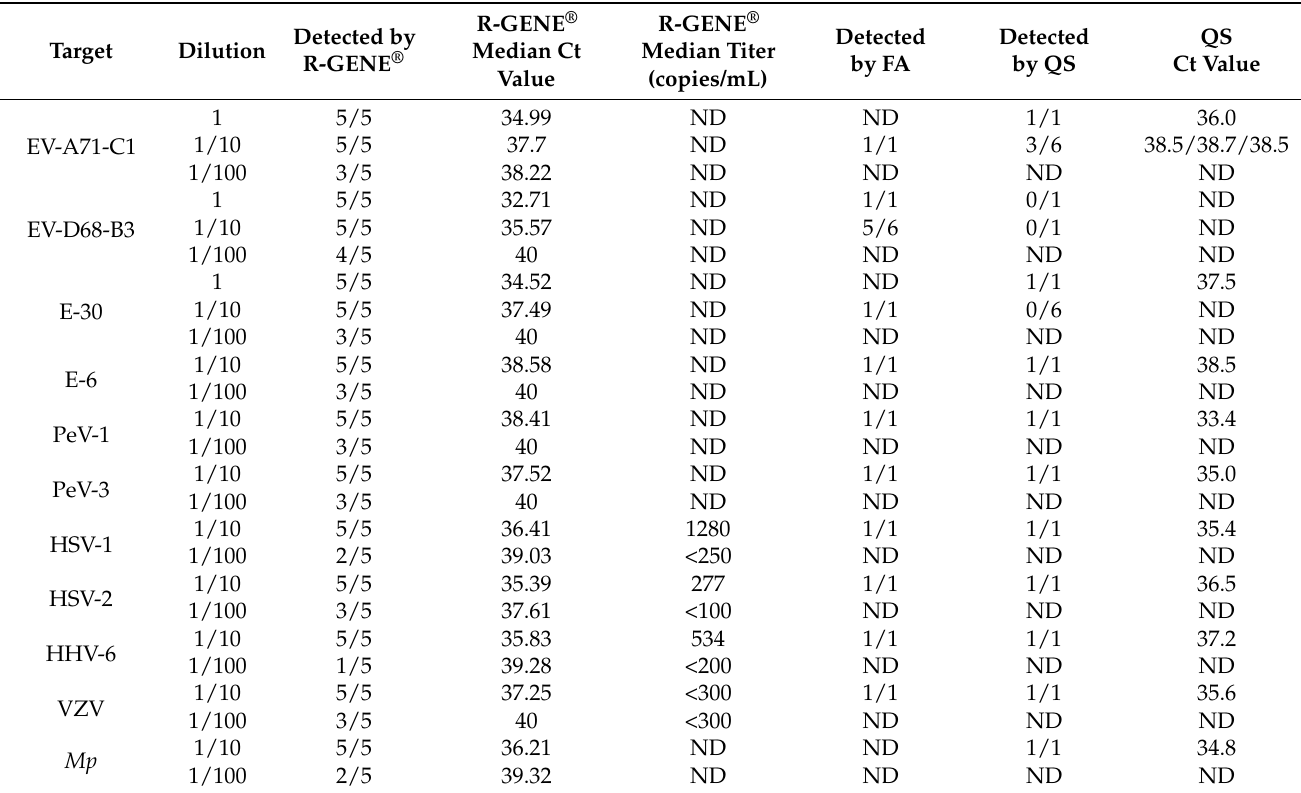
Table 2. Detections of low viral and Mp loads with R-GENE ® PCR assays, QS and